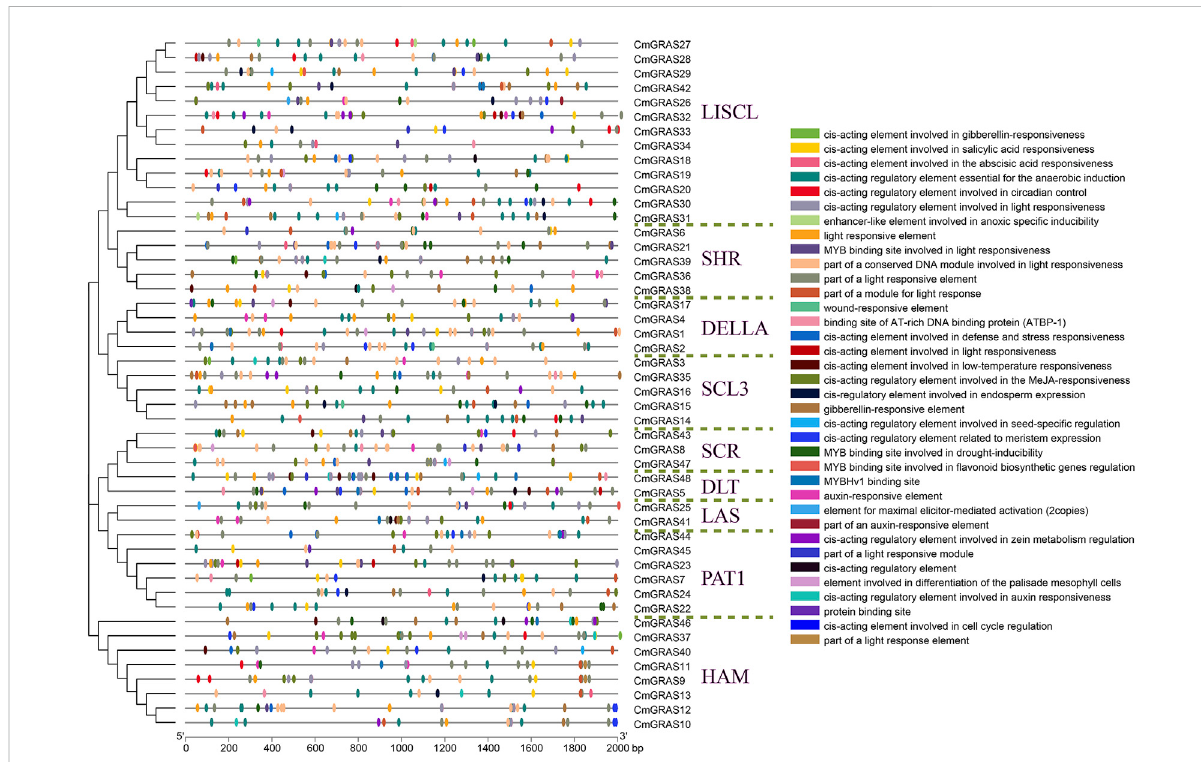
FIGURE 5 Cis -acting elements in the promoter region of CmGRAS genes. The left side dendrogram shows the phylogenetic tree of CmGRAS genes. The distributionof cis -acting elements in the2,000 bp upstream promoter are shown. The different functions of cis -acting elements are represented by different colors, as shown on the